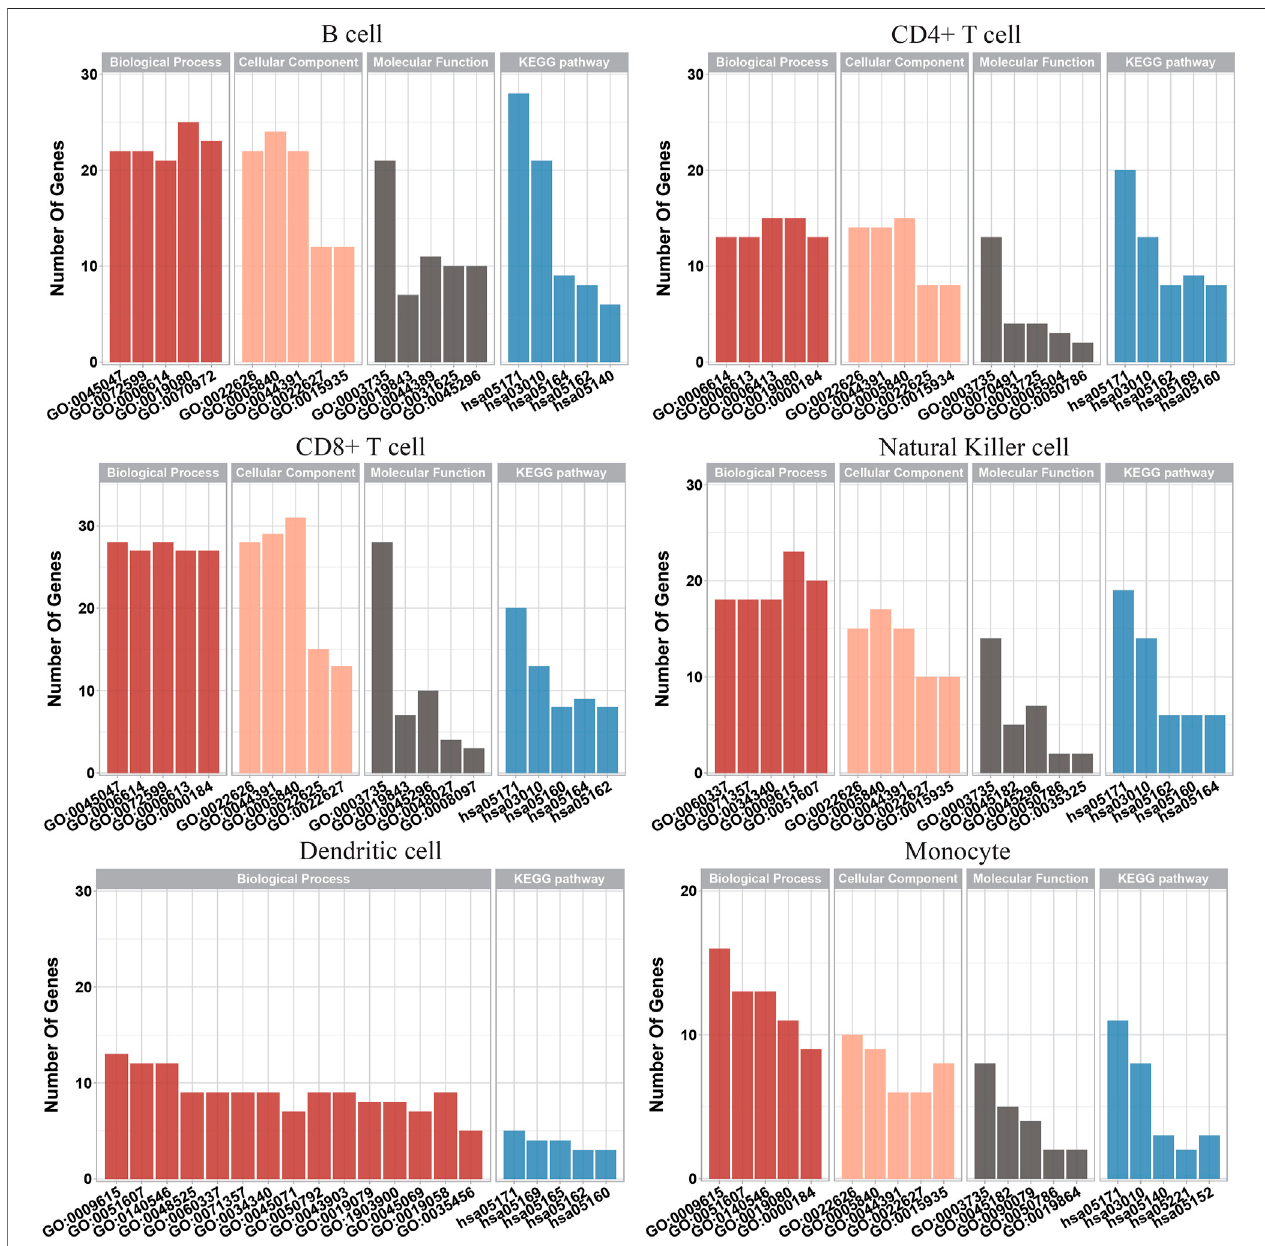
FIGURE 6 | Gene Ontology enrichment and Kyoto Encyclopedia of Genes and Genomes pathway enrichment analysis on optimum genes among the six types of immune cells.